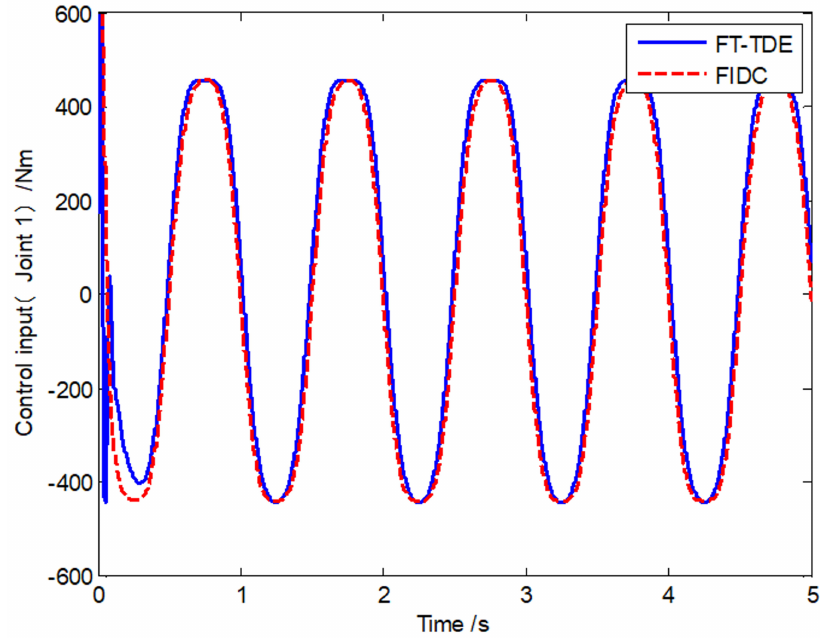
Figure 3. Control input of Joint 1.